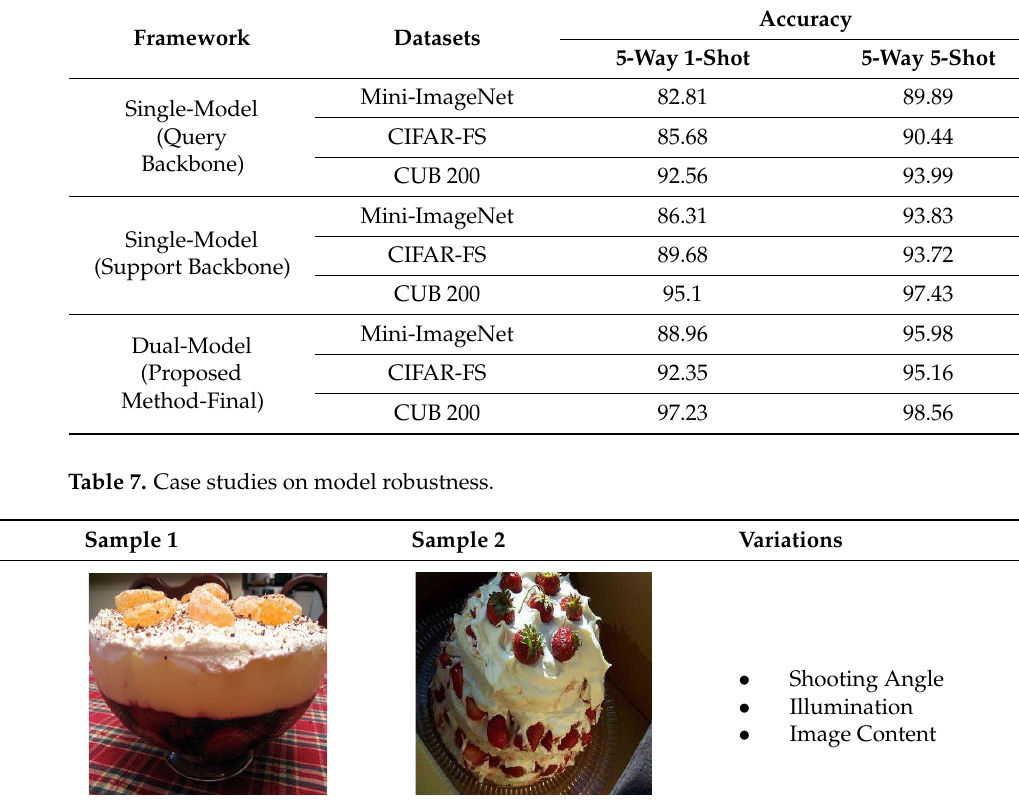
Table 6. Classification accuracy comparison of single-model and dual-model.